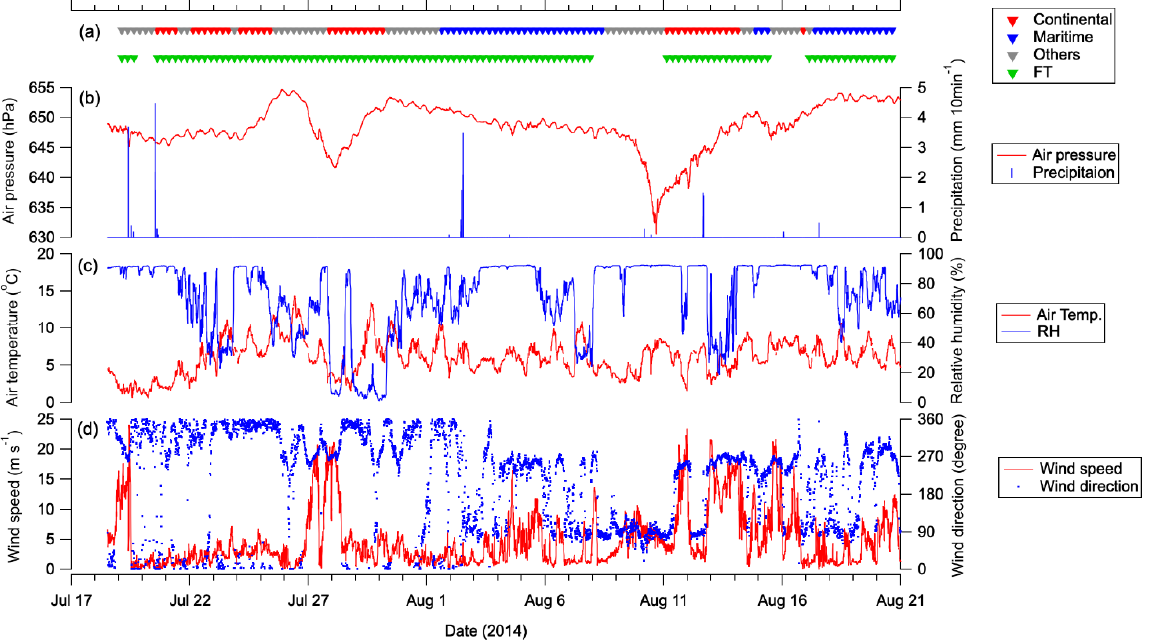
Figure 3. Temporal variations of ( a ) air mass origins, ( b ) air pressure (red line), precipitation (blue sticks), ( c ) air temperature (red line), relative humidity (blue line), ( d ) wind speed (red lines) and wind direction (blue dots).